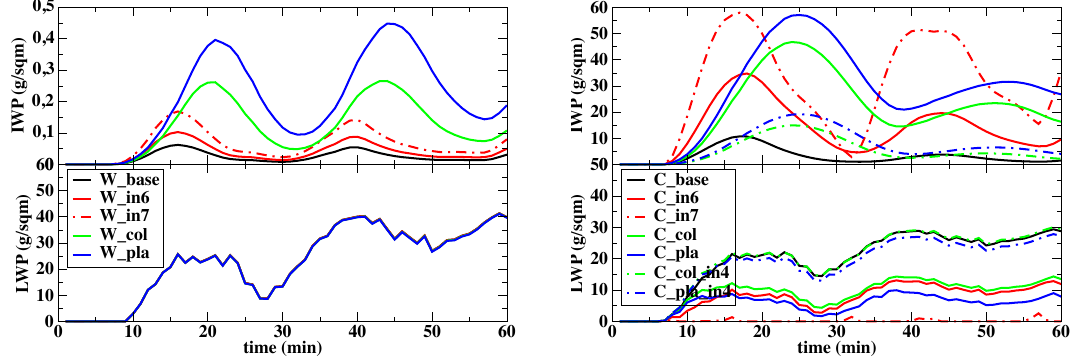
Figure 19. Liquid (lower panel) and ice water paths (upper panel) for case 1 (left) and case 2 (right). Comparison of the sensitivities with respect to IN number and ice particle